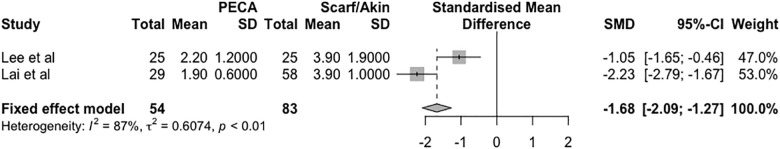
Forest plot of the meta-analysis of the studies evaluating the difference in the visual analog pain scale score at one day postoperatively.